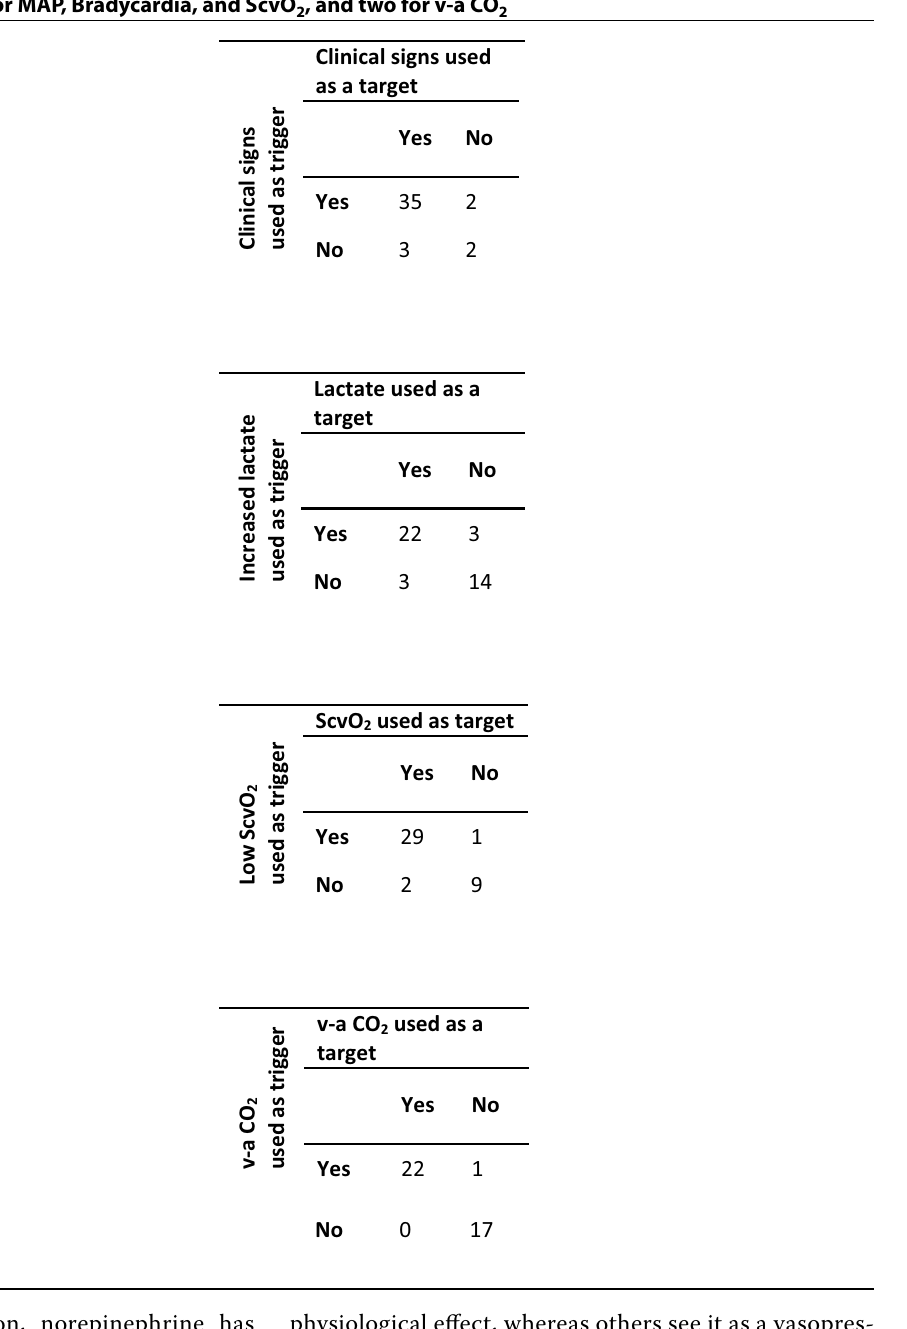
Table 4 Answers from 42 experts on questions Q5 and Q6 from Fig. 1, where the view on triggers and targets for inotropic use are combined. Conditional answers for Q5 in triggers (marked yellow in Fig. 1) are not represented in this table. There was one conditional Q5 answer for MAP, Bradycardia, and ScvO